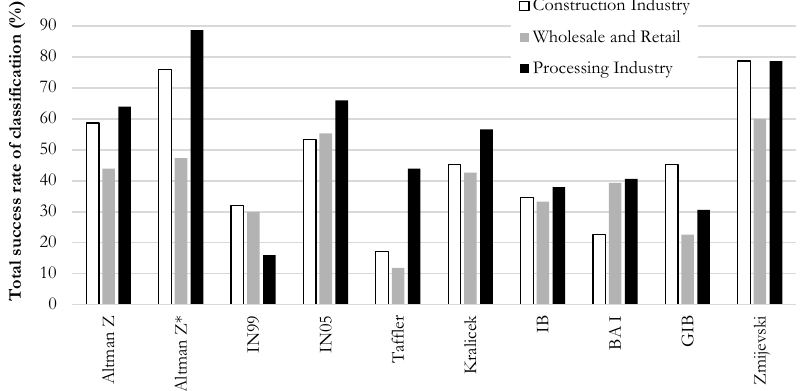
Fig. 4 – Evaluation of models in different branches based on the total success rate (%). Source: own